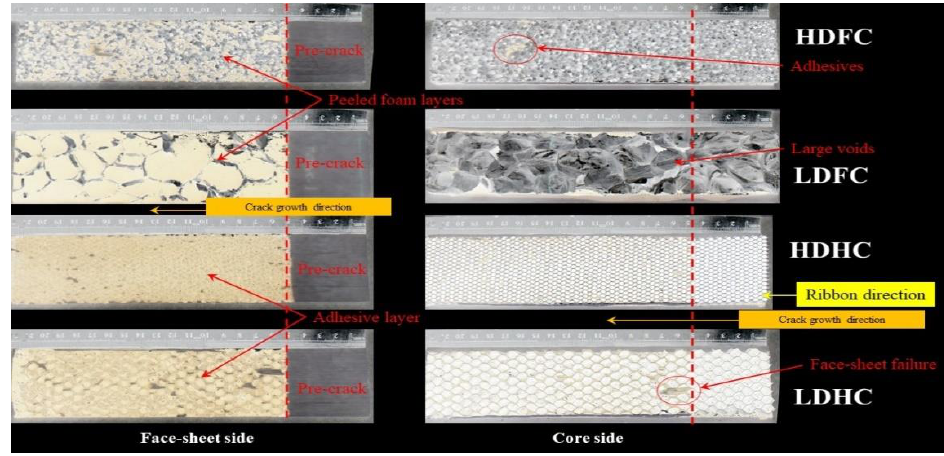
Figure 17. Detailed visualization of the fractured surface of the SCB specimens.